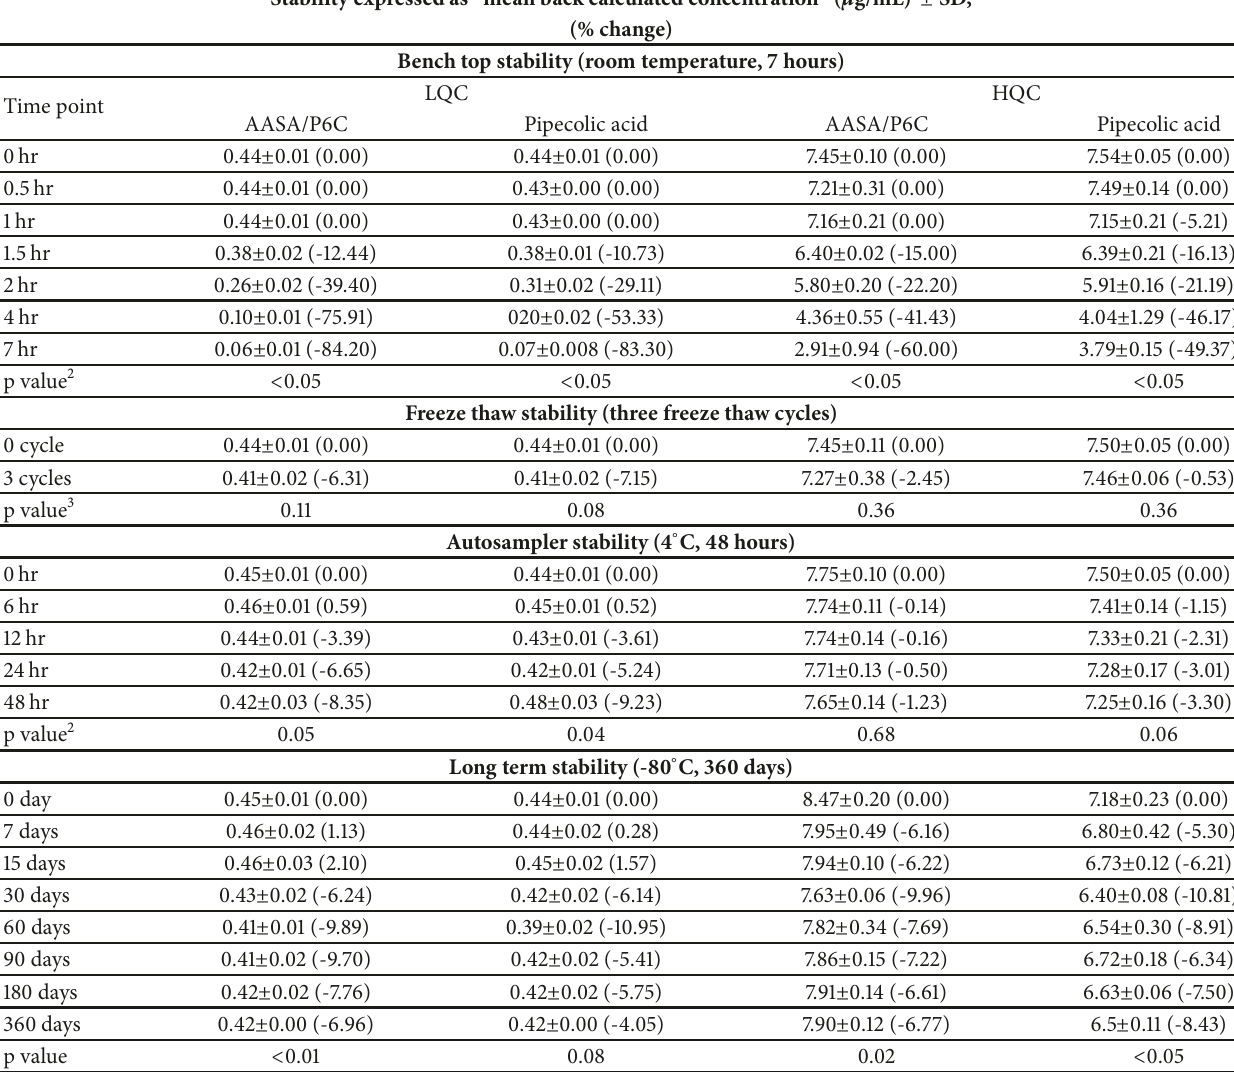
Table 3: Results of benchtop, freeze thaw, autosampler, and long term stability for alpha-amino adipic semialdehyde/piperidine-6-carboxylic acid and pipecolic